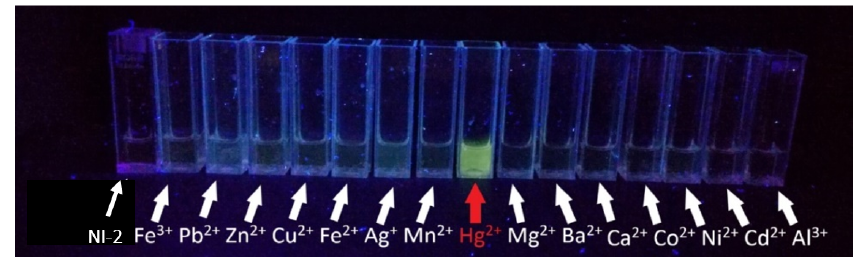
Figure 9. NI-2 in the presence of metal ions in MeOH/buffer